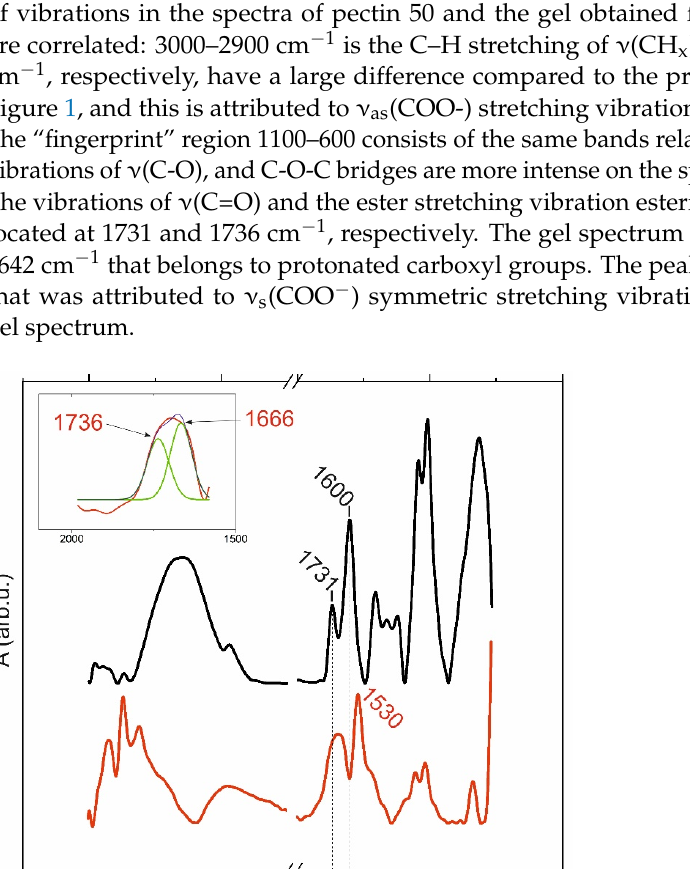
Figure 1. FTIR absorption spectra: black spectrum, powder of pectin with DE 0%; red spectrum, gel obtained from pectin 0 solution with a concentration of 1.25%. The selected area is the range of vi- brations of carboxyl groups from the spectrum of the gel .